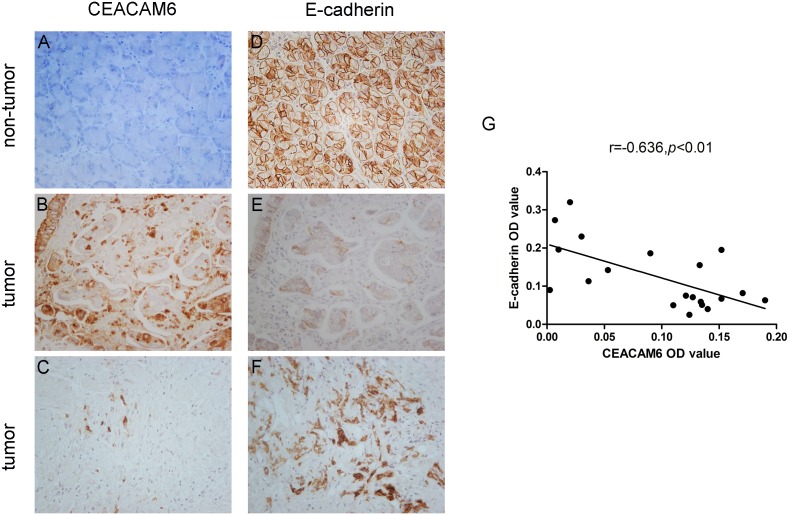
Expression of CEACAM6 and E-cadherin in gastric tissues.(A) Negative CEACAM6 expression in non-tumor gastric mucosa. (B, C) Positive or negative CEACAM6 expression in GC samples. (D) Strong positive E-cadherin expression in non-tumorous gastric mucosa. (E, F) Negative or positive E-cadherin expression in GC samples. (G) Negative correlation between CEACAM6 and E-cadherin expression was detected in GC tissues (R = −0.636, P<0.01) (200×).